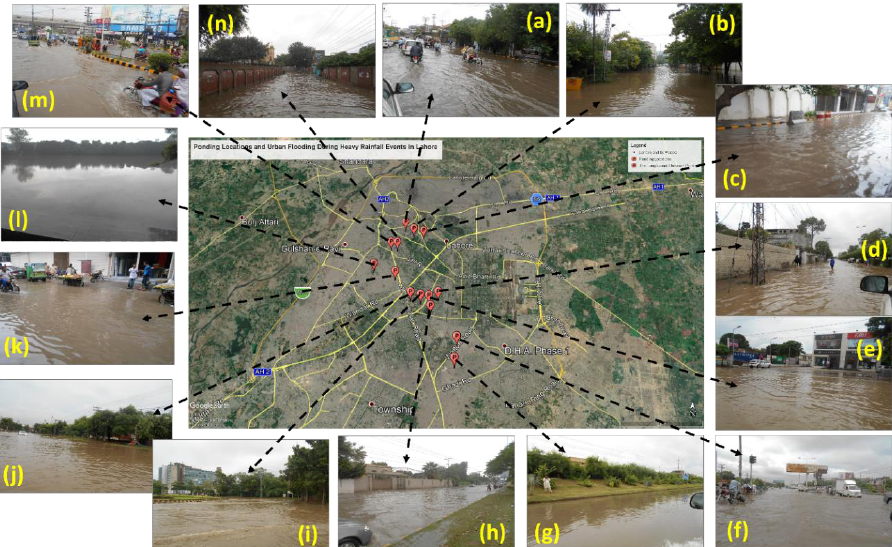
Figure 5. Inundation condition and depth on ponding roads during monsoon season ( a ) Cooper Road (ponding depth = 10 inch); ( b ) Kashmir Road (ponding depth = 8 inch); ( c ) Davis Road (ponding depth = 6 inch); ( d ) MM.Alam Road (ponding depth = 4 inch); ( e ) Liberty Market (ponding depth = 6 inch); ( f ) Walton Road (ponding depth = 8 inch); ( g ) Khayaban-e-Iqbal Road (ponding depth = 6 inch); ( h ) Ali Zaib Road (ponding depth = 8 inch); ( i ) Hafeez Kardar Road and Roundabout (ponding depth = 8 inch); ( j ) Gaddafi Stadium (ponding depth = 6 inch); ( k ) Sultan Ahmed Road (ponding depth = 6 inch); ( l ) Doongi Ground (ponding depth = 10 inch); ( m ) Qartuba Chowk, Mazang Chungi (ponding depth = 8 inch); ( n ) Waris Road (ponding depth = 6